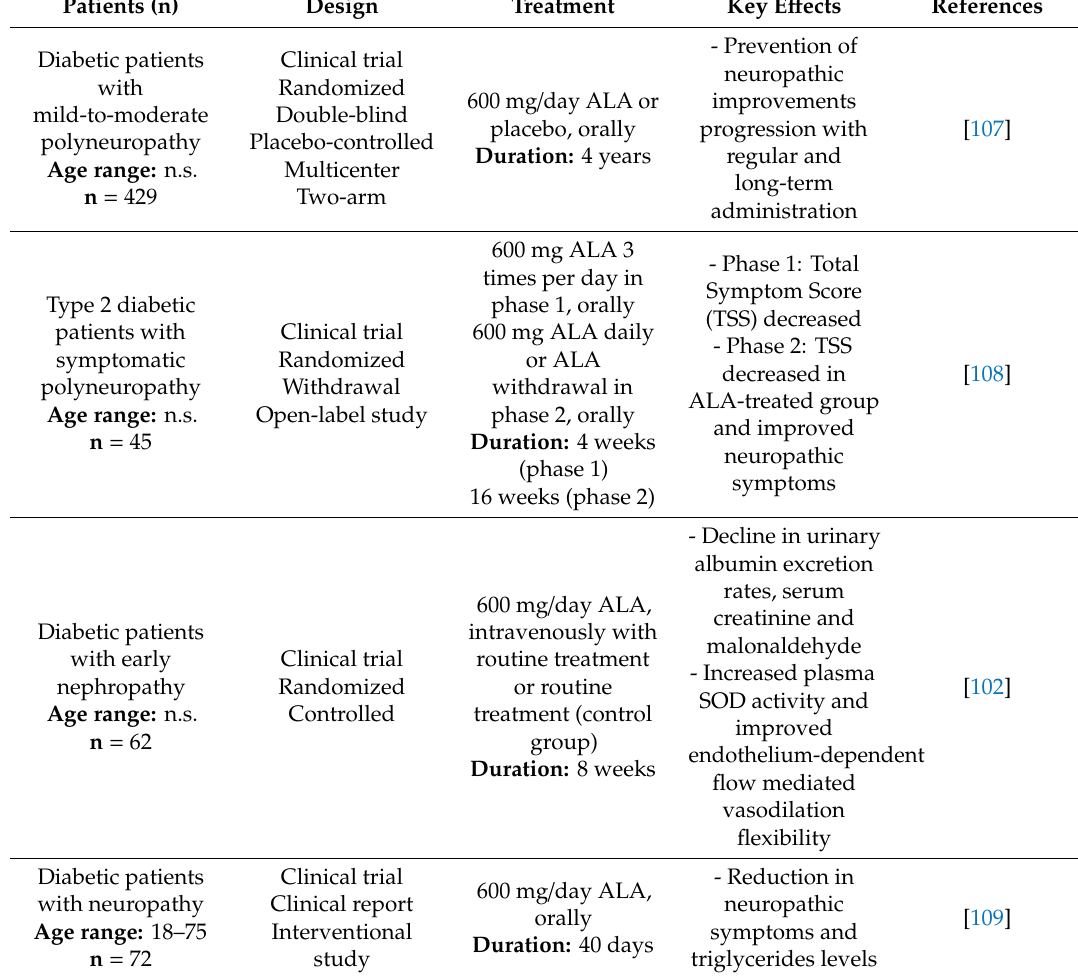
Table 1. E ff ects of ALA in diabetic patients with